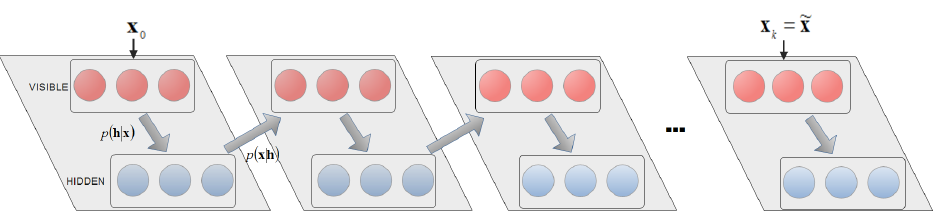
(cid:68) (cid:69) v i h j , we initialize the visible units of the model